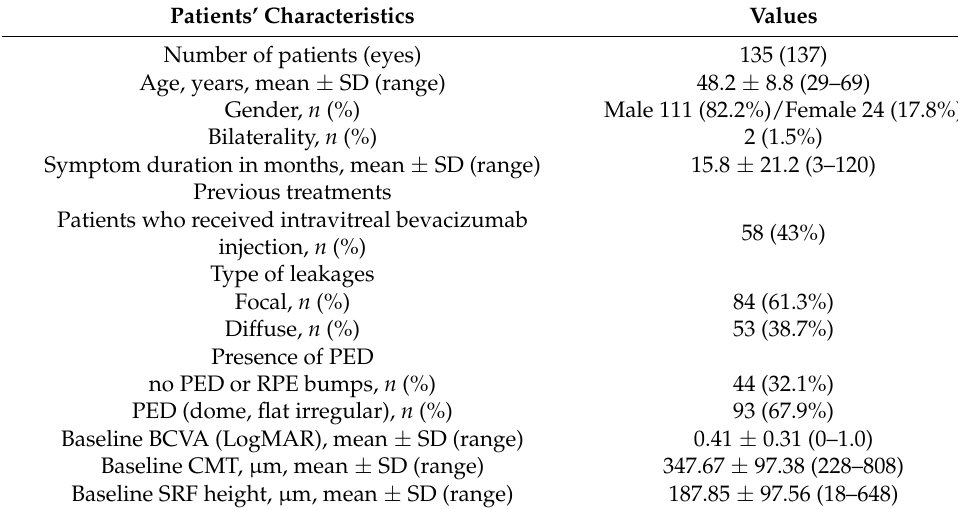
Table 2. Baseline demographics and clinical findings of total patients with chronic central serous chorioretinopathy (CSC).